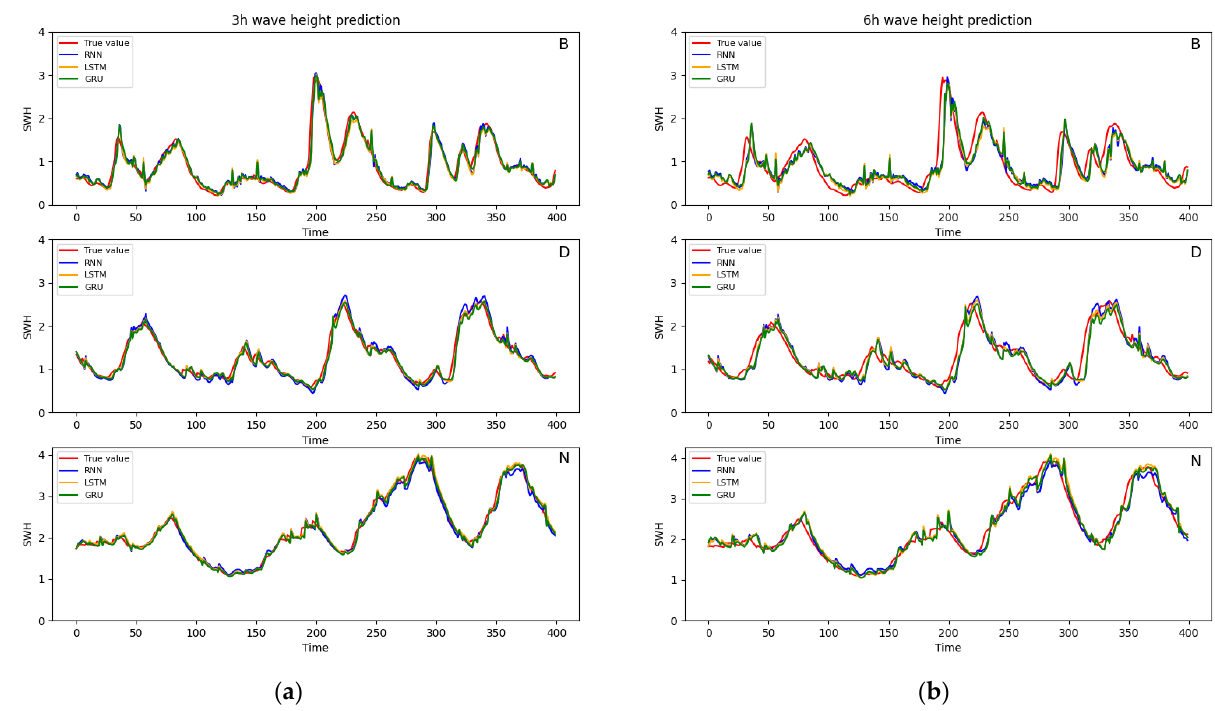
Figure 8. Three-hour and 6 h prediction results with more instructions. The abscissa represents the time, the ordinate represents the significant wave height, the red line represents the real significant wave height, the blue line represents the predicted value of the RNN, the yellow line represents the predicted value of LSTM, and the green line represents the predicted value of GRU. ( a ) represents the 3 h forecast for different locations; ( b ) represents the 6 h forecast for different